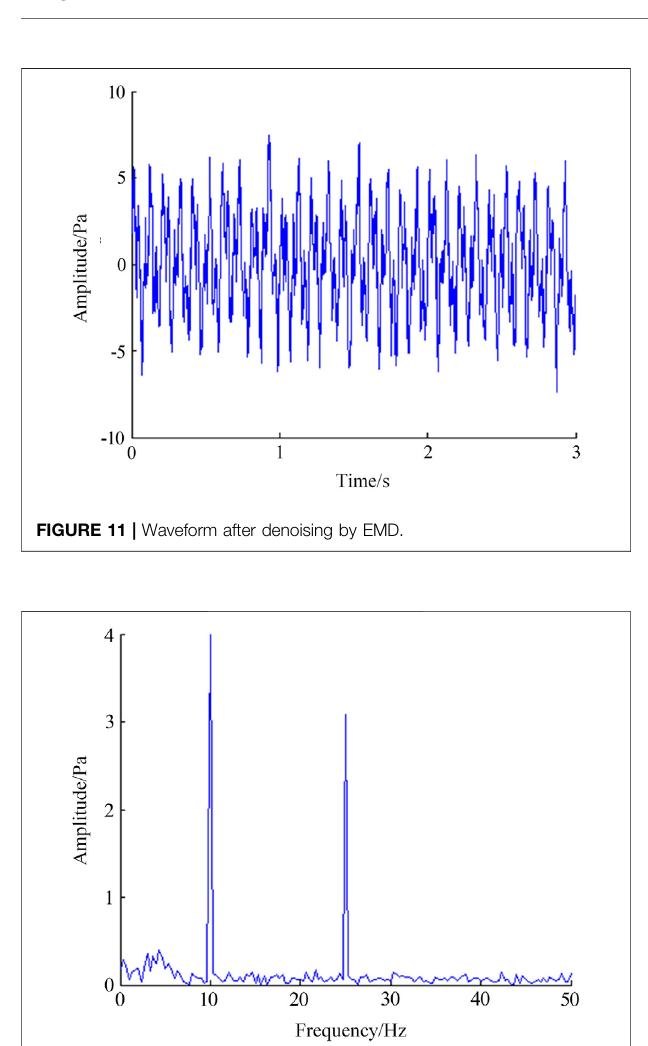
FIGURE 12 | Spectrum of the signal after denoising by EMD.